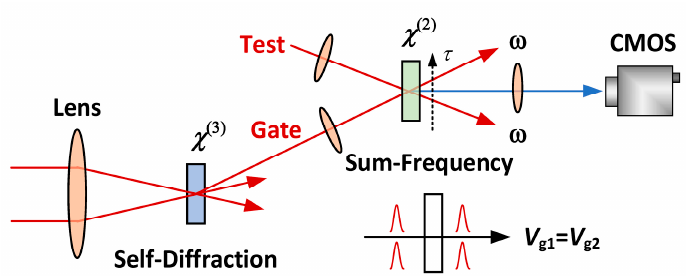
Figure 1. Schematic of a single-shot four-order autocorrelator. The gate pulse is generated by frequency-degenerate four-wave mixing process.